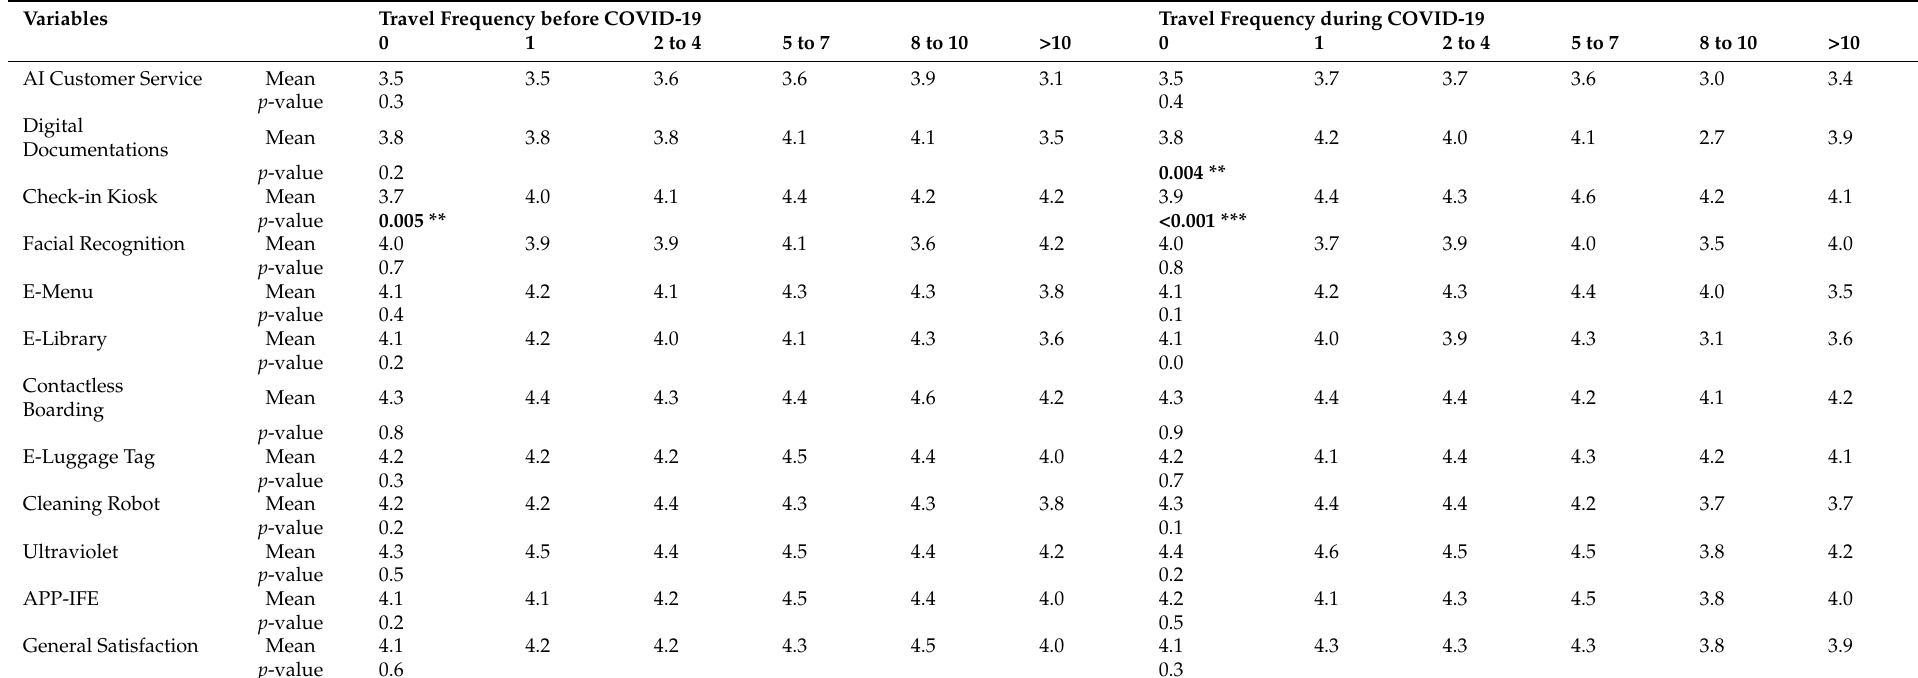
Table A3. ANOVA results for 12 variables show the relationship between travel frequency before and during